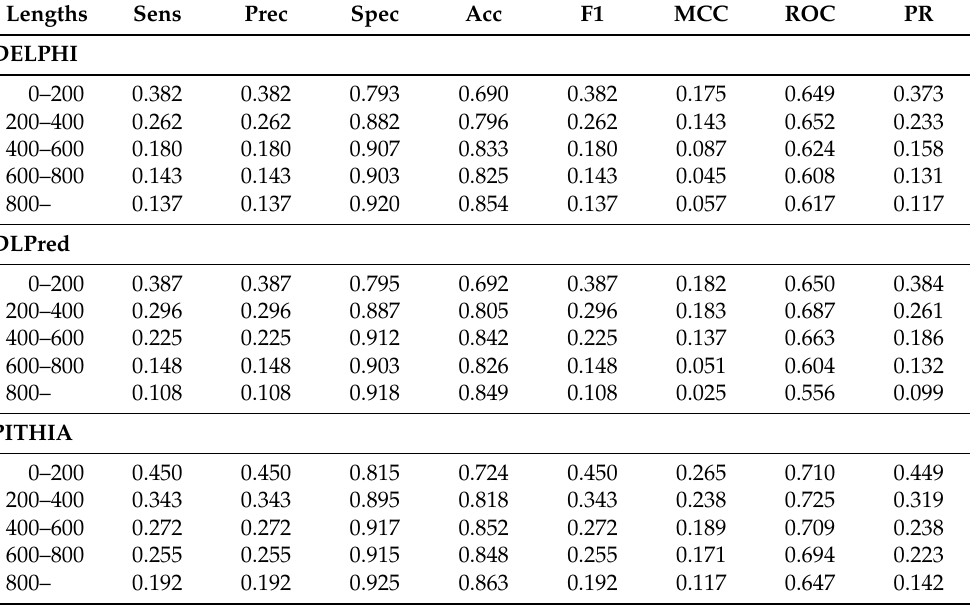
Table 2. Length comparison on all datasets